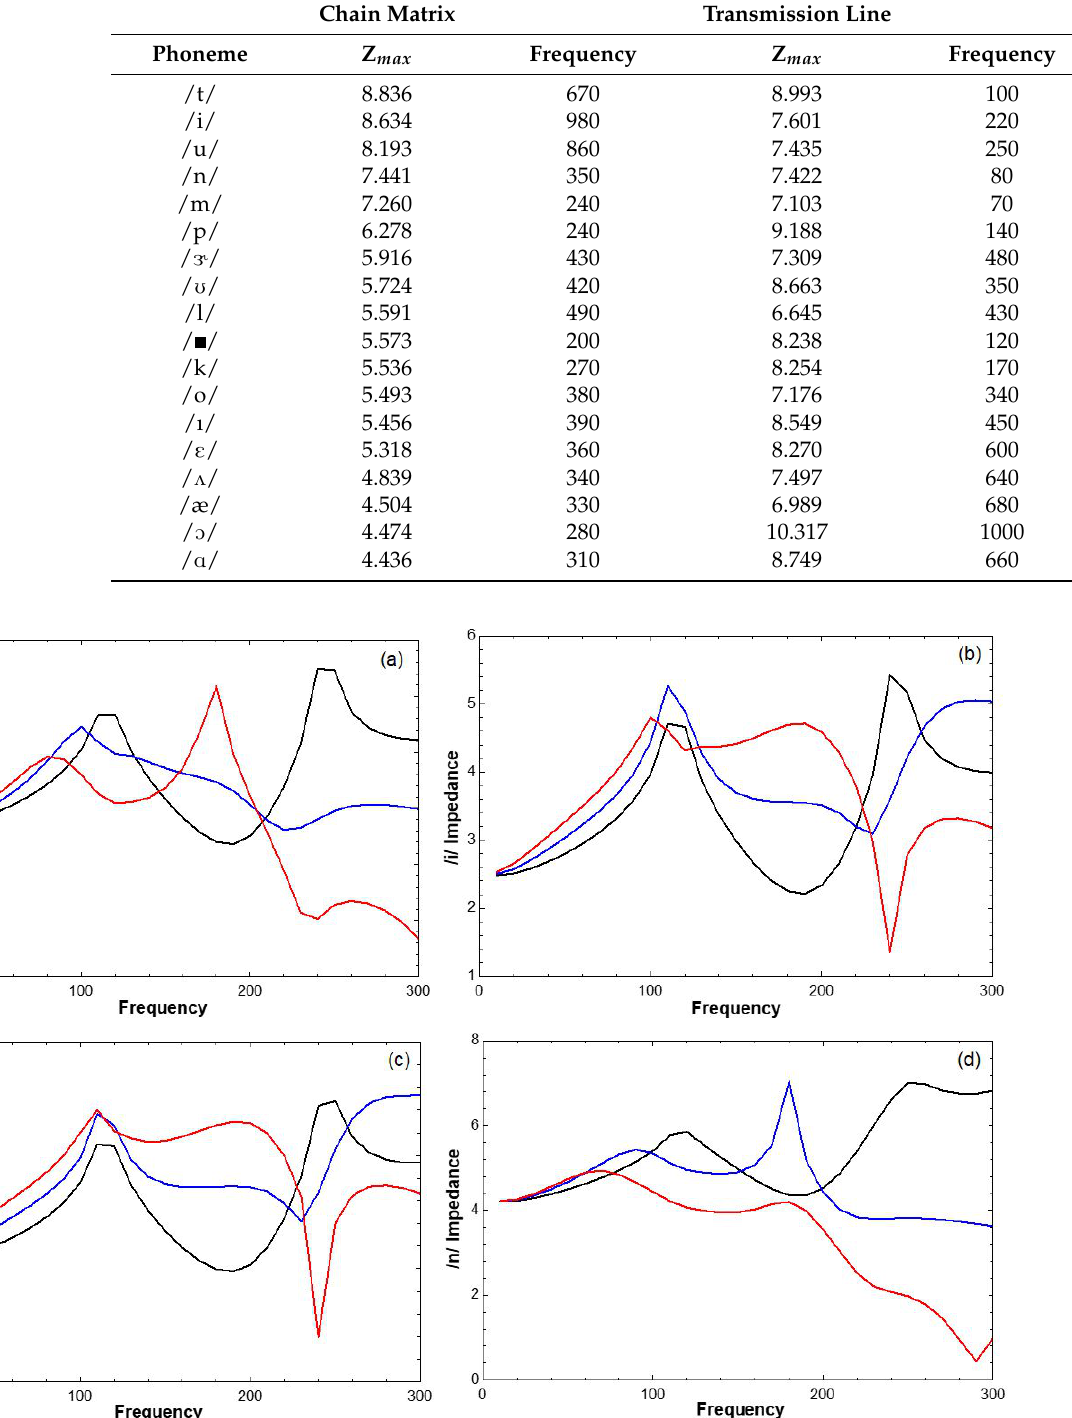
Table 3. Frequencies at which maximum impedance occurs versus maximum impedance value on log scale for both impedance calculation methods for various phonemes. Maximum impedance (Z max ) is in units of dyne-s/cm 5 and frequency is units of Hz.